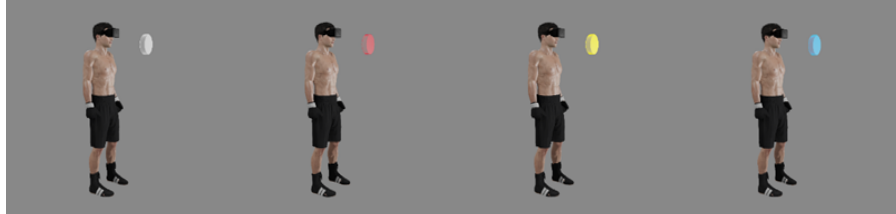
Figure 3. Visualization of the test used for analyzing complex reaction in VR (gray — waiting for the stimulus, red — no reaction, yellow — right hand reaction, blue — left hand reaction).